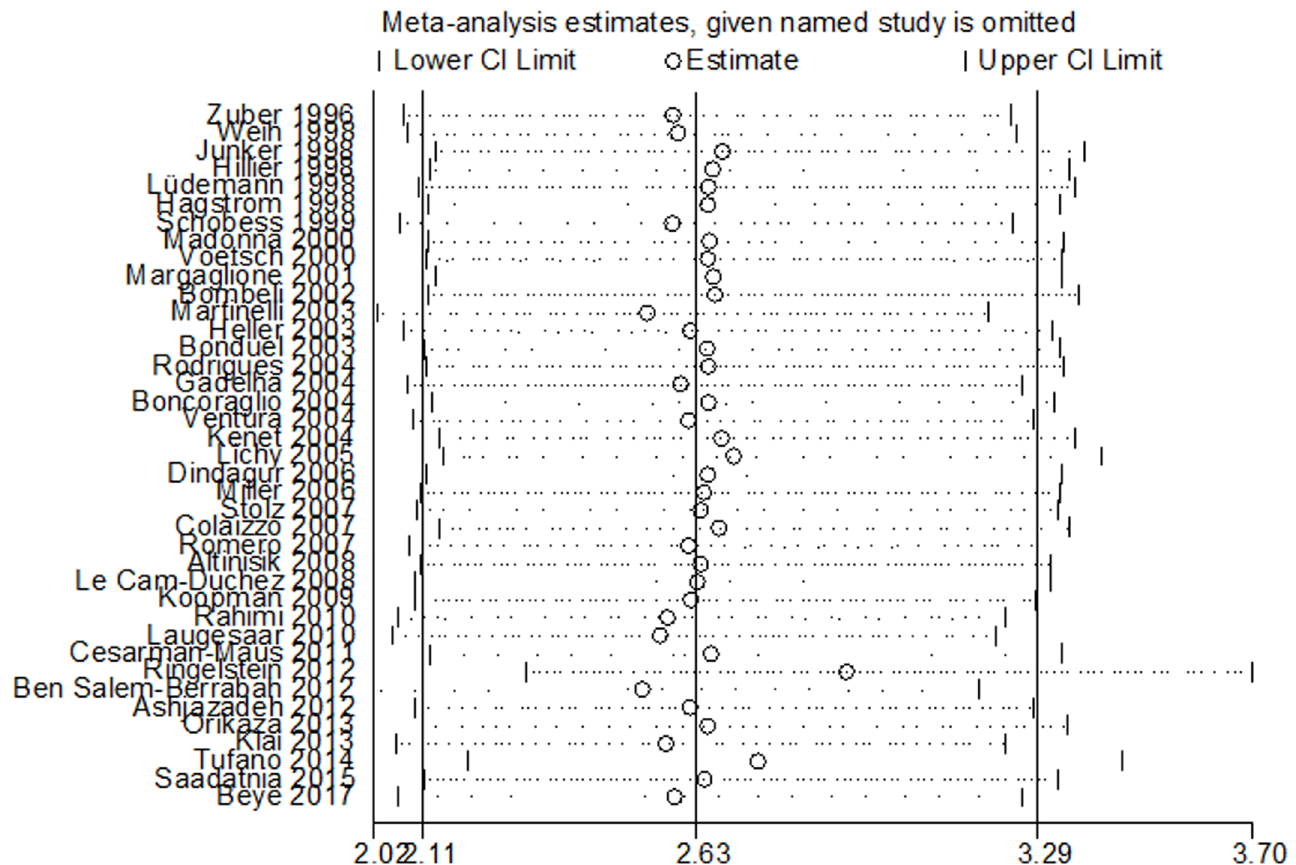
Fig 6. Sensitivity analysis of the overall prevalence of FVL. FVL, Factor V Leiden; CVT, cerebral venous